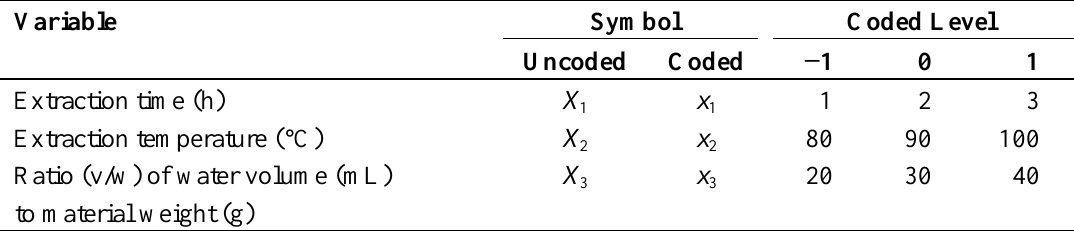
Table 4. Coded and uncoded values of the experimental